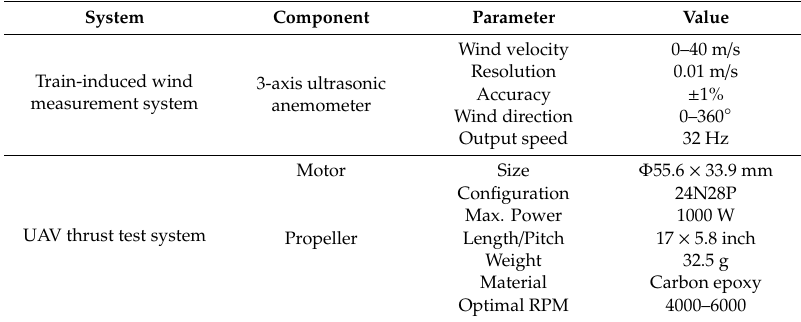
Table 1. Detailed specifications of the main components of the train-induced wind and UAV thrust measurement systems.